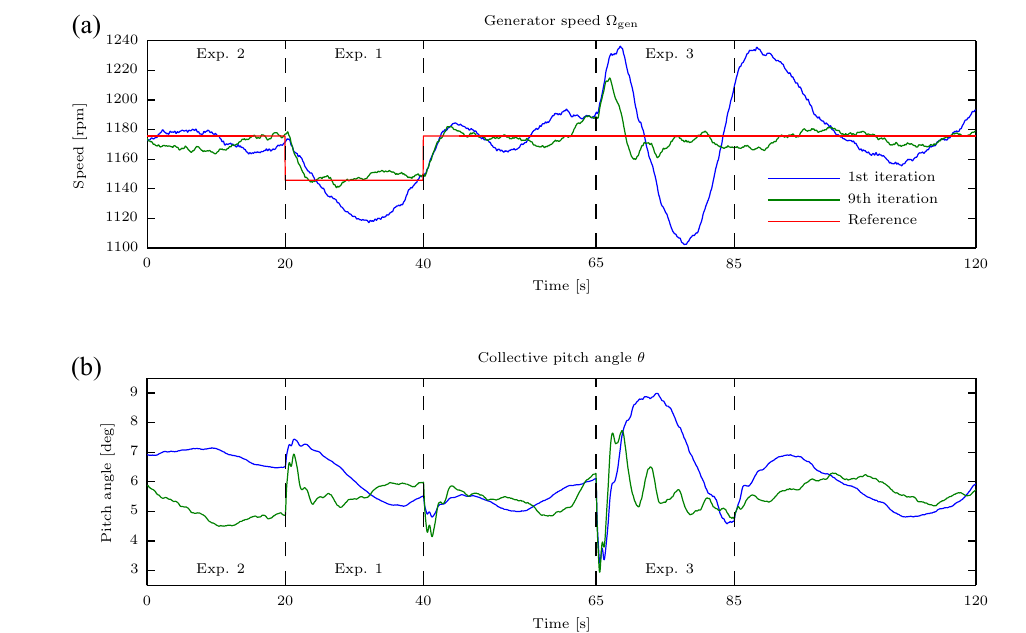
Figure 16. Comparison of responses during the first and ninth iterations. Results shown are obtained for a wind speed of 14ms − 1 with 4% turbulence intensity. The measured generator speed and reference input are shown in the upper plot, and the lower plot displays the pitch response.